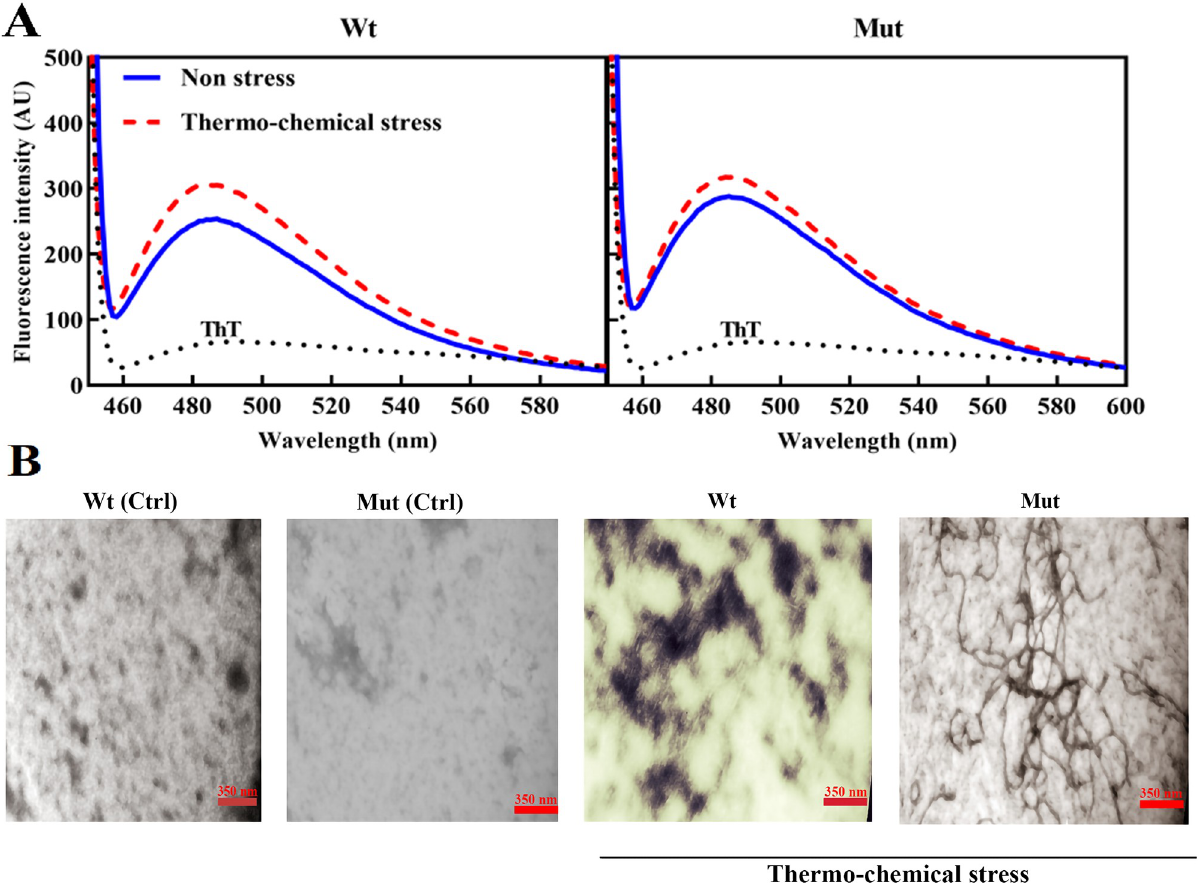
Fig 11. Comparing amyloidogenic properties of D109A and wild-type α B-crystallins before and after thermochemical stress. The results of ThT fluorescence assay ( A ) and TEM analysis ( B ) are indicated in this figure.